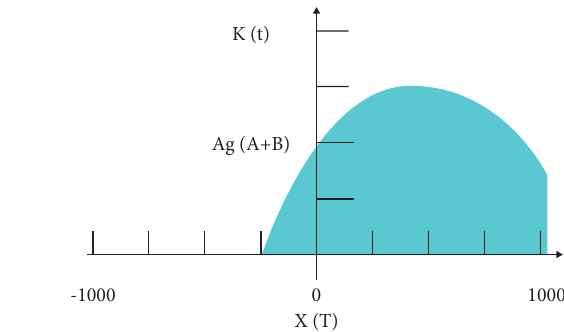
Figure 5: Inner hair cell model.